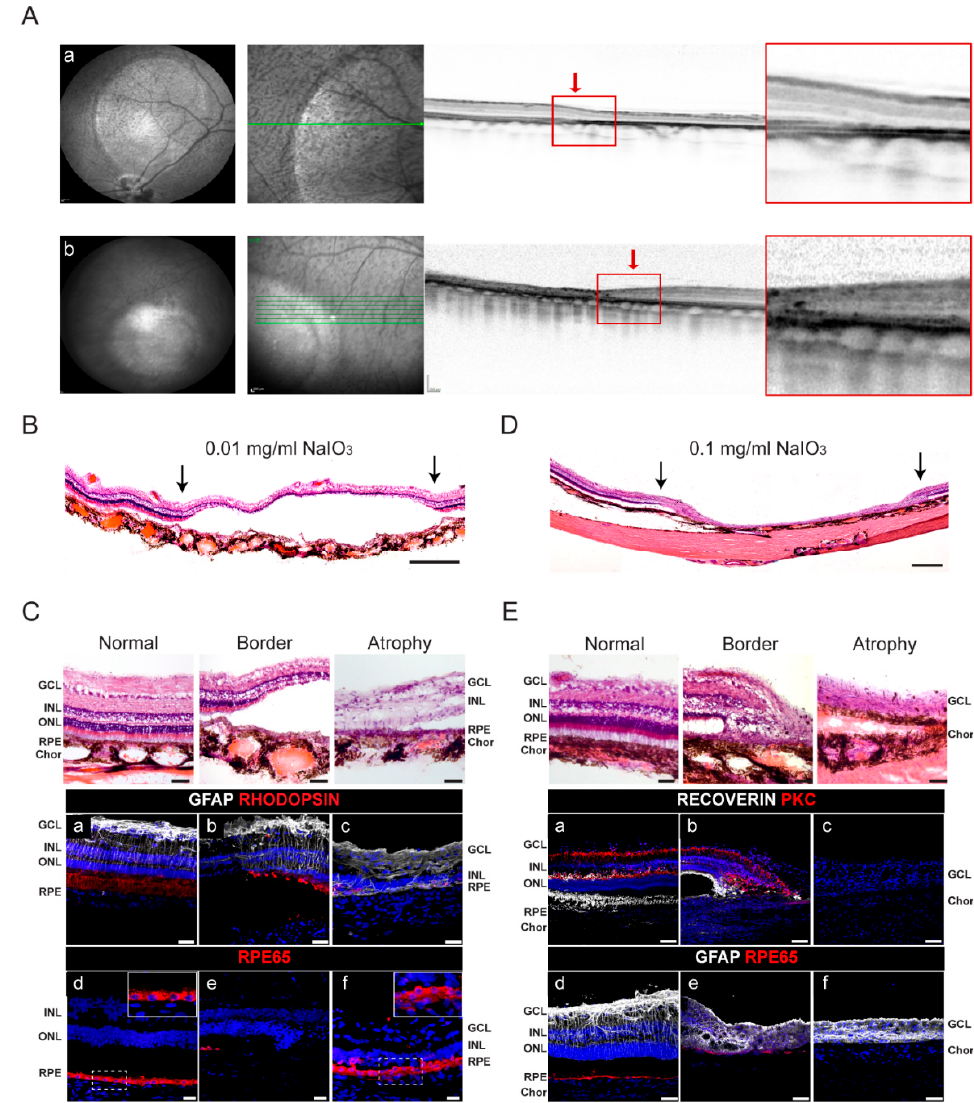
Figure 2. Selective and severe atrophies induced by subretinal injection of NaIO 3 in porcine retinas. ( A ) Fundus porcine retinas at 1 month after NaIO 3 subretinal injection (0.2 mL) at a concentration of 0.01 mg/mL (a). A well-demarcated round area is shown by IR fundus imaging after NaIO 3 injection in pig 4. The 30° fundus IR image with overlying position of B- Scan (middle panel; green line) and cross-sectional SD-OCT B-scan demonstrate selective loss of the outer retinal layers. The outer plexiform layer and inner nuclear layer are directly on the damaged RPE, as occurs in GA in humans. (b) By contrast, a severe round atrophy is shown by IR and SD-OCT imaging after NaIO 3 injection in pig 9. A transition zone (red arrows) is observed between the atrophic and healthy retina in SD-OCT in both (a) and (b). Red squares indicate the enlargement of the atrophic border. ( B ) Photomerge composition of hematoxylin and eosin (H&E) staining of the lesion induced with 0.01 mg/mL NaIO 3 in pig 4. Arrows indicate the border of the atrophy. Scale bar: 200 μ m. ( C ) (Top panels) Images of H&E staining showing different parts of porcine healthy and atrophic retina of the lesion induced with 0.01 mg/mL NaIO 3 . Scale bars: 50 μ m. (Bottom panels) Immunofluorescence images of different areas (healthy (a,d), border (b,e), and mild atrophy (c,f)) labeled with glial fibrillary acidic protein (GFAP), retinal pigment epithelium-specific 65 kDa protein (RPE65) and rhodopsin. Insets in ( C (d) and (f)) show an enlargement of the RPE layer stained with RPE65. Scale bars: 50 μ m. ( D ) Photomerge composition of H&E staining of the lesion induced with 0.1 mg/mL NaIO 3 in pig 8. Arrows indicate the border of the atrophy. Scale bar: 200 μ m. ( E ) (Top panels) Images of H&E staining showing different parts of porcine healthy and atrophic retina of the lesion induced with 0.1 mg/mL NaIO 3 . Scale bars: 50 μ m. (Bottom panels) Im- munofluorescence images of the different zones of the eyes (healthy (a,d), border (b,e), and severe atrophy (c,f)) labeled